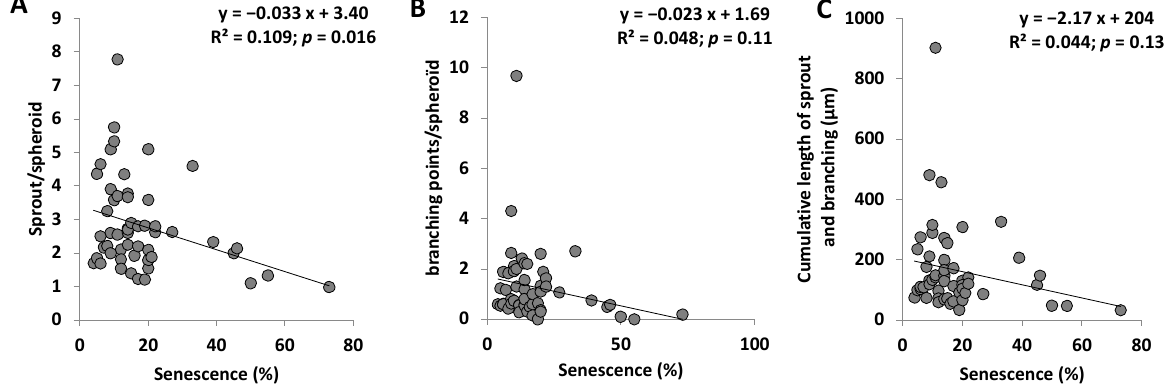
Figure 4. Relation between senescence and angiogenic functions of ECFC. ( A ) Senescence accord- ing to the number of sprouts per spheroid. ( B ) Senescence according to the number of branching points per spheroid. ( C ) Senescence according to the cumulative length per spheroid. R 2 and p are from Pearson correlation.